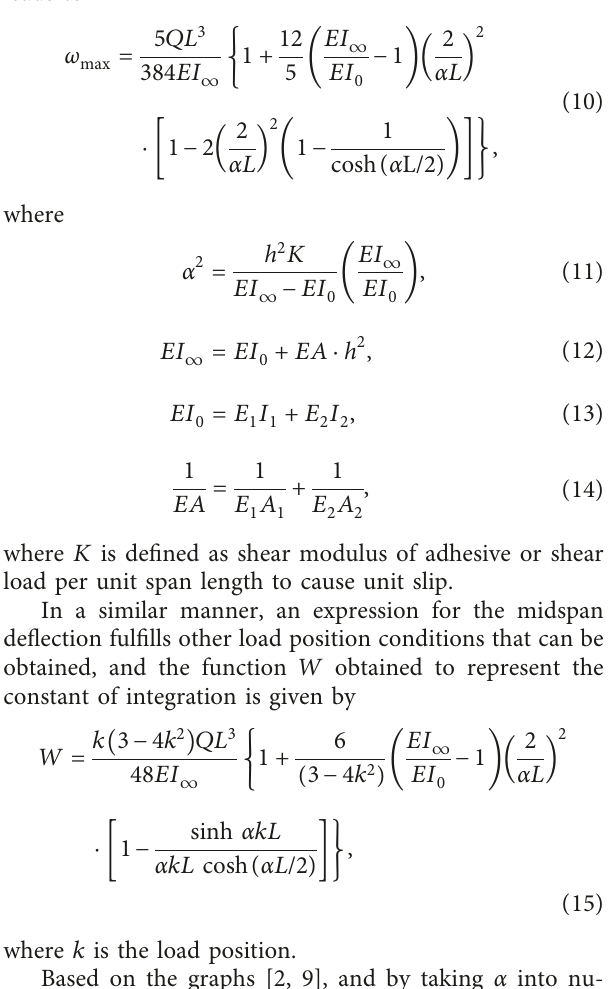
Figure 4: The mechanics model of bond-slip behavior between interface of steel and timber.